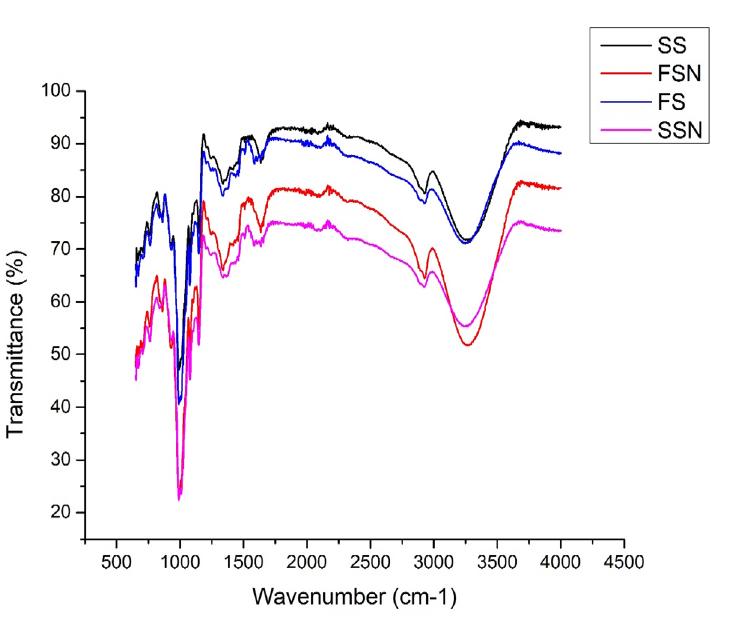
Figure. 3. ATR-FTIR spectra of native and nano starch samples. FS, FSN, SS and SSN represent native foxtail millet starch, nano foxtail millet starch, native sorghum starch and nano sorghum starch,